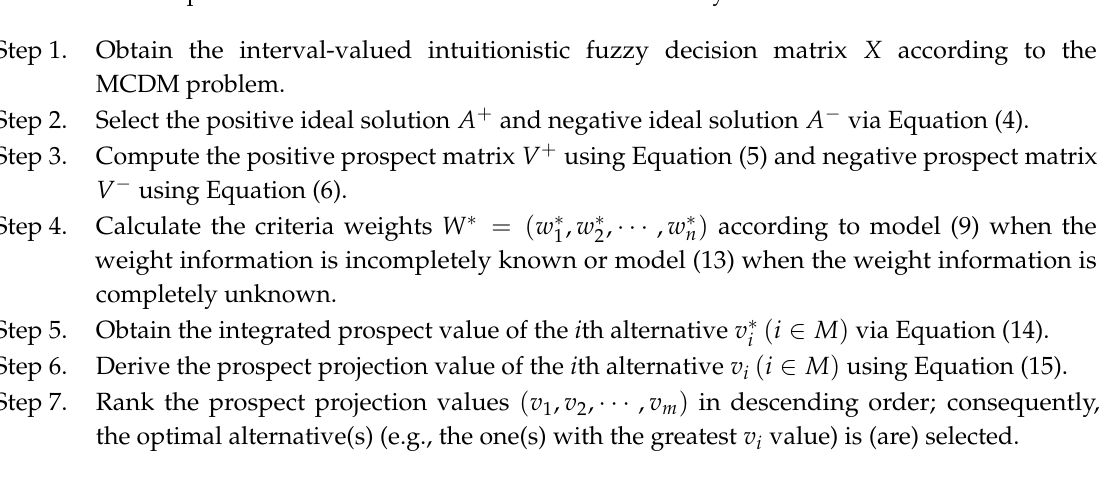
v  on * v . Figure 3. Prospect projection of v + on v ∗ i i i i